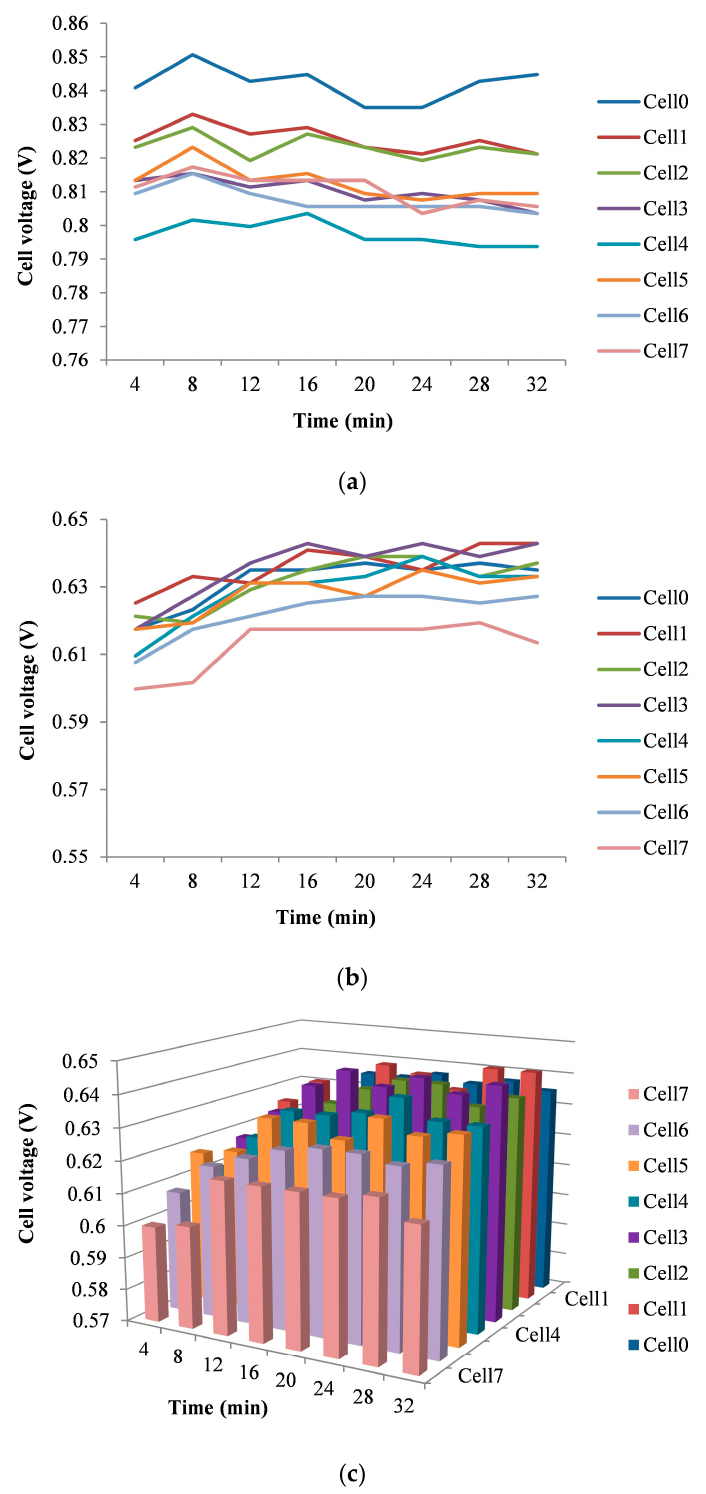
Figure 13. Evolution of each cell voltage: ( a ) Open circuit; ( b ) Connected load; ( c ) Connected load with three-dimensional chart.